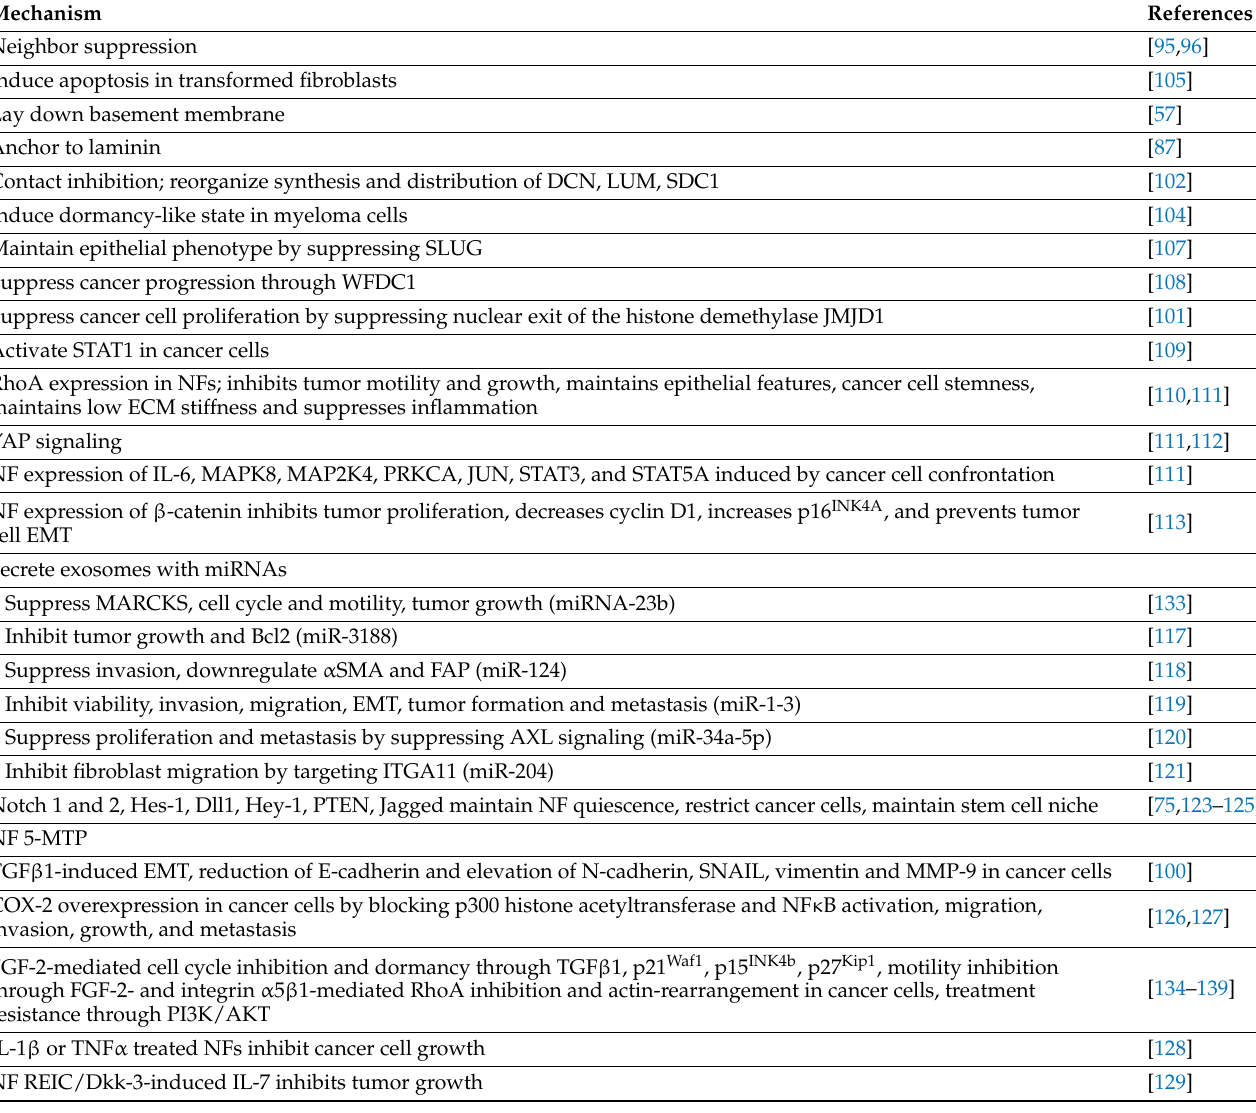
Table 1. Normal fibroblasts suppress cancer cell malignant